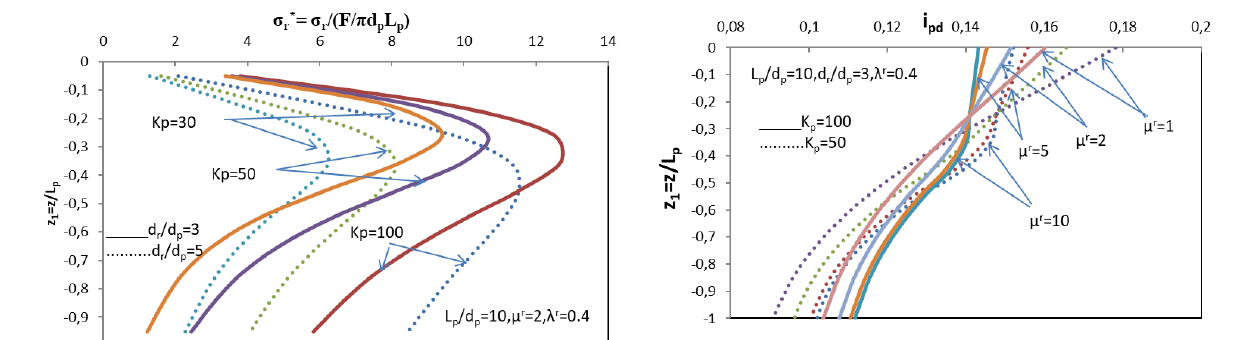
Figure 14: Variation of normalized radial stresses, σ r* = σ with the normalized depth, z μ r , and comparative strengthening, K